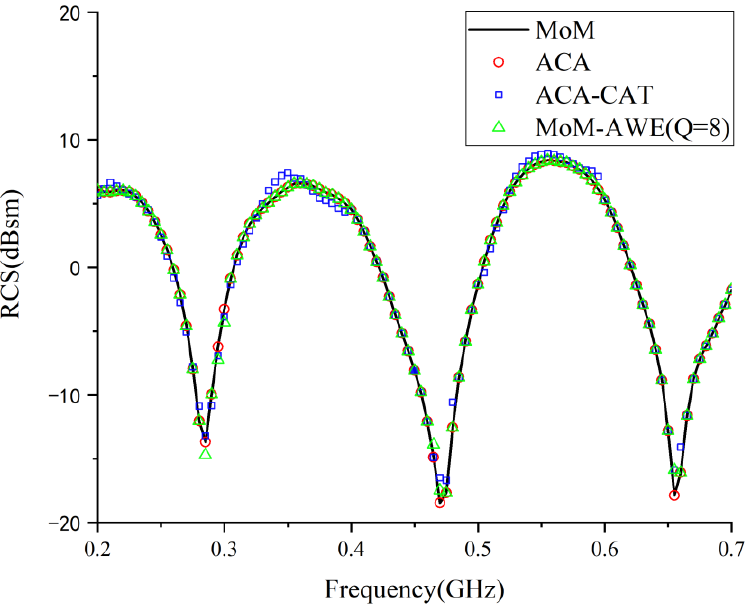
Figure 14. RCS with frequency for the dual missile by four different methods.